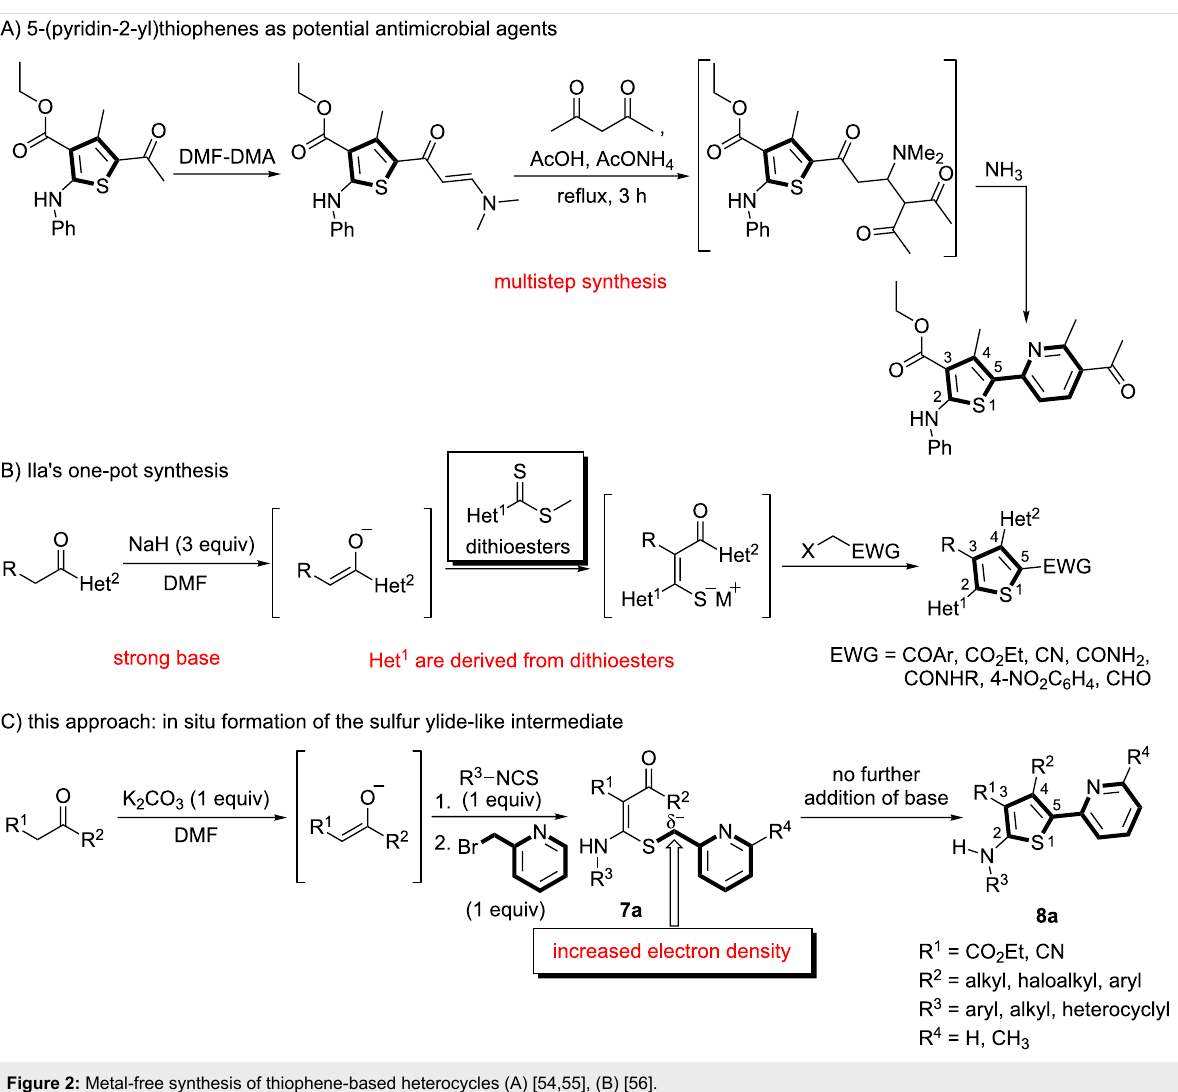
Figure 2: Metal-free synthesis of thiophene-based heterocycles (A) [54,55], (B) [56].